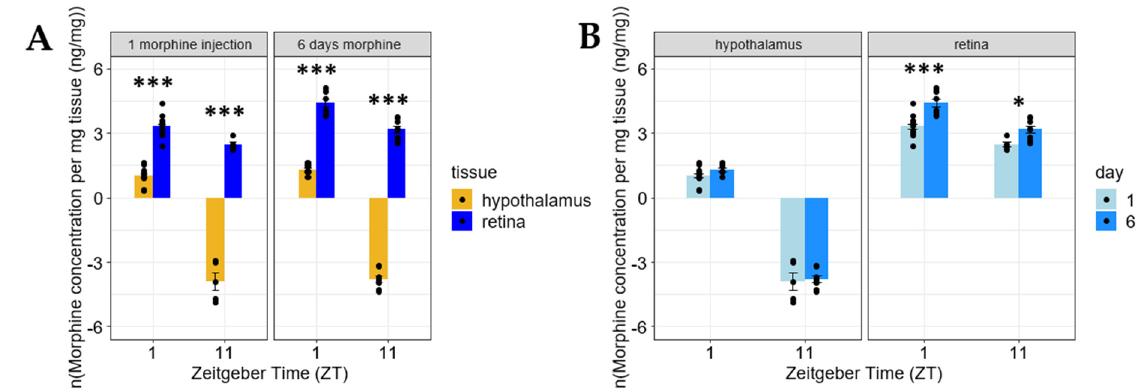
Figure 4. Morphine accumulates in the retina, but not the hypothalamus. ( A ) Retinal morphine concentrations exceed hypothalamic morphine concentrations at 1 (ZT 1) and 11 (ZT 11) hours following chronic morphine exposure (6 days of morphine treatment). ( B ) Morphine accumulates in the retina, but not the hypothalamus following chronic morphine exposure. Two-way ANOVA with a Tukey post hoc adjustment was performed on a natural logarithmic (ln) scale. Data are presented as the mean ± SEM with 5–17 mice per group (* = p < 0.01, *** = p < 0.0001).